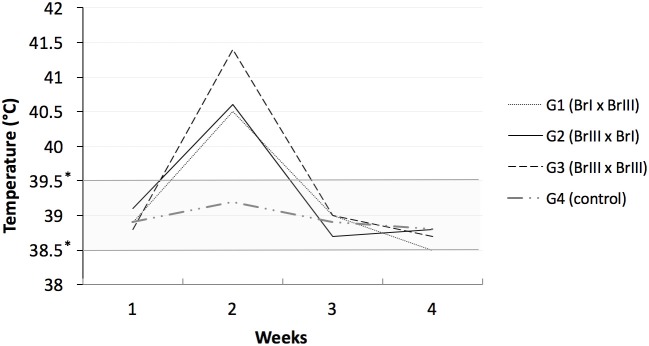
Sheep rectal temperatures after experimental prime infection using oocysts of Toxoplamsa gondii isolates TgCatBr71 (genotype BrI or TOXODB#6) and TgCatBr60 (genotype BrIII or TOXODB#8) *low and high limits of normal temperatures.